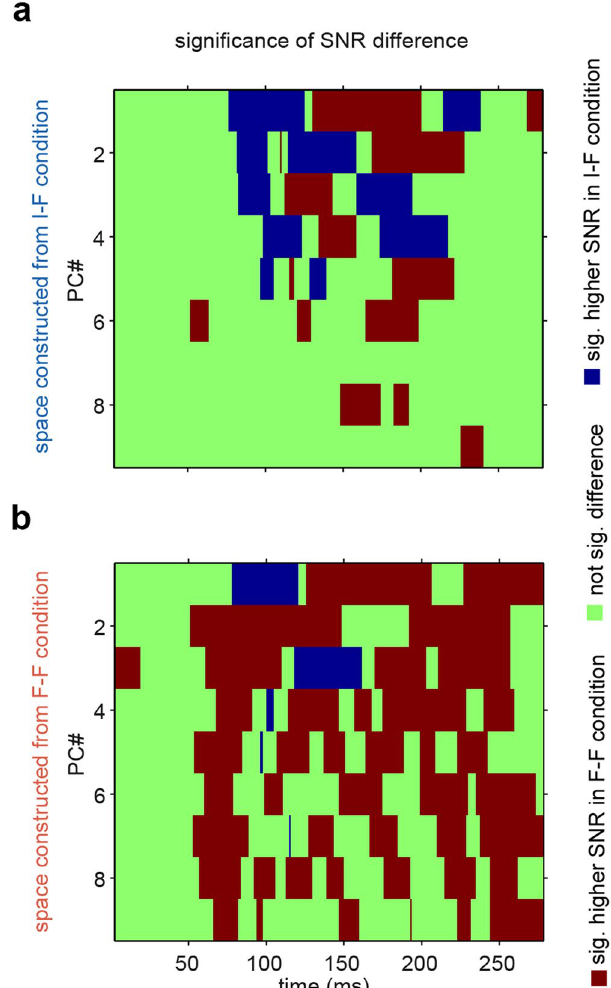
Figure 6. SNR between face and all other animal images. The SNR was calculated for each direction of the two spaces and for responses under each condition and then significance of difference between the responses under the F-F condition and responses under the I-F condition are shown for ( a ) the space constructed from the I-F condition, and ( b ) the space constructed from the F-F condition. Significance was assessed using a one-sample z-test (p < 0.01, FDR corrected, q <